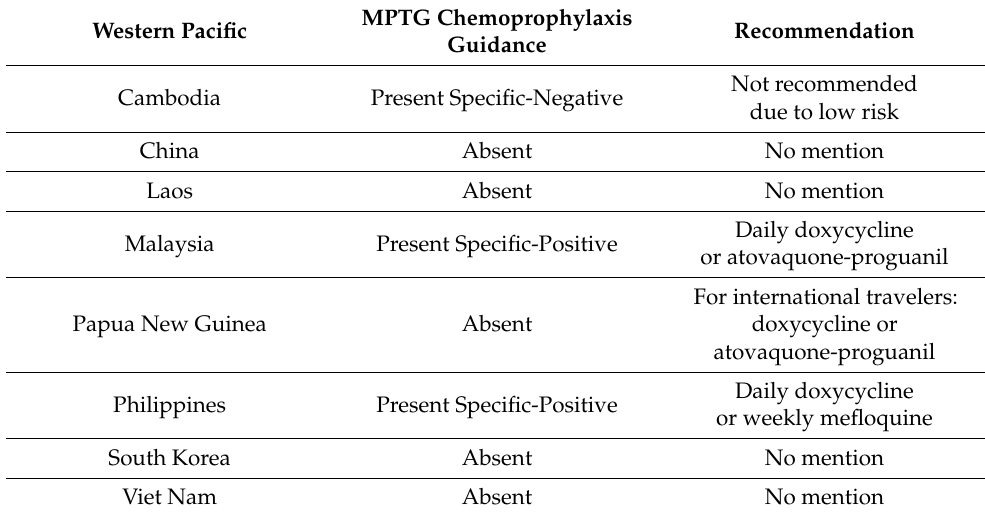
Table 7. Survey results for Western Pacific